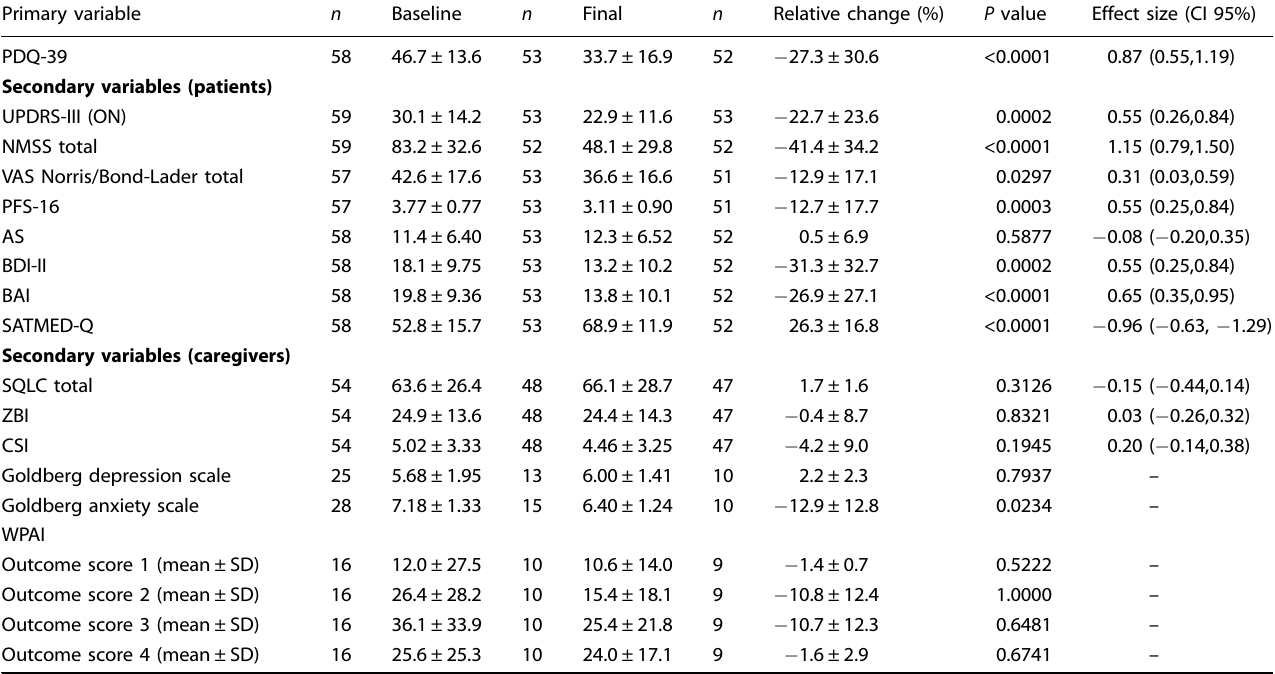
Table 3. Mean change ± SD from baseline to fi nal visit (6 months ± 15 days) in the primary and secondary study endpoints ( fi nal score — baseline score).